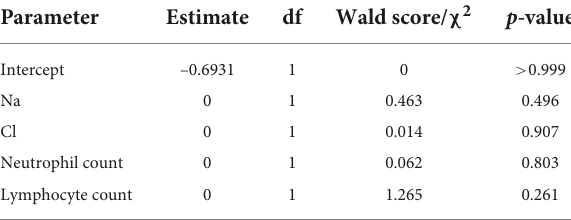
TABLE 4 Stepwise selection of variables predicting the need for supplemental oxygen based on clinical characteristics and laboratory biomarkers of patients with